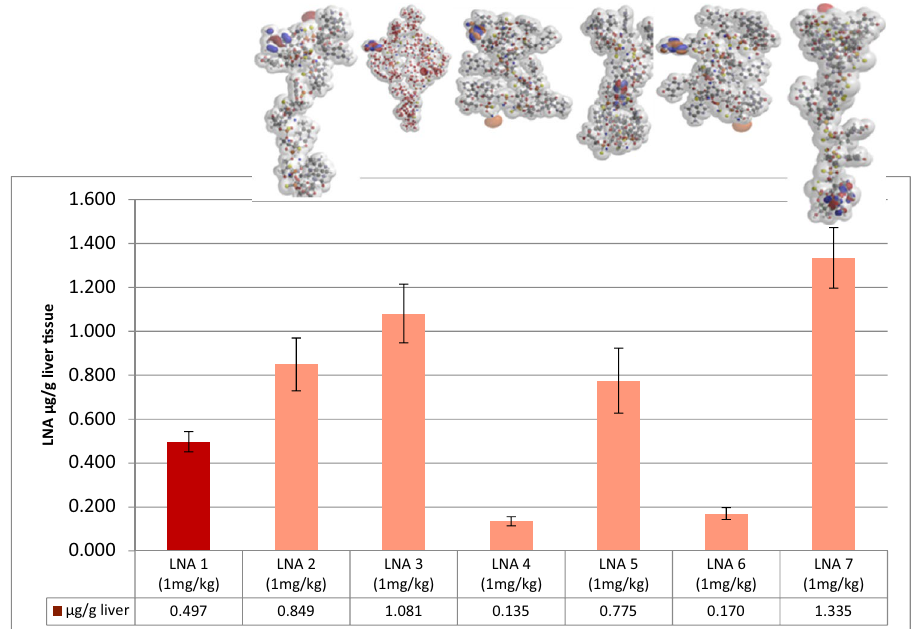
Figure 3. Liver uptake of LNA diastereoisomers targeting ApoB-100. Diversity of diastereoisomers on oligonucleotide concentration in liver of mice (C57BL/6qBom) (n = 5) dosed once intravenously at 1 mg/ kg at day 0 and taken down day 3 (60 h). LNA oligonucleotide concentration (µg/g tissue) determined by hybridization-ELISA. Dark red color LNA 1 shows random mixture of stereoisomers. Light color show stereo- defined isomers with identical nucleobase sequence and nucleoside design as LNA 1.